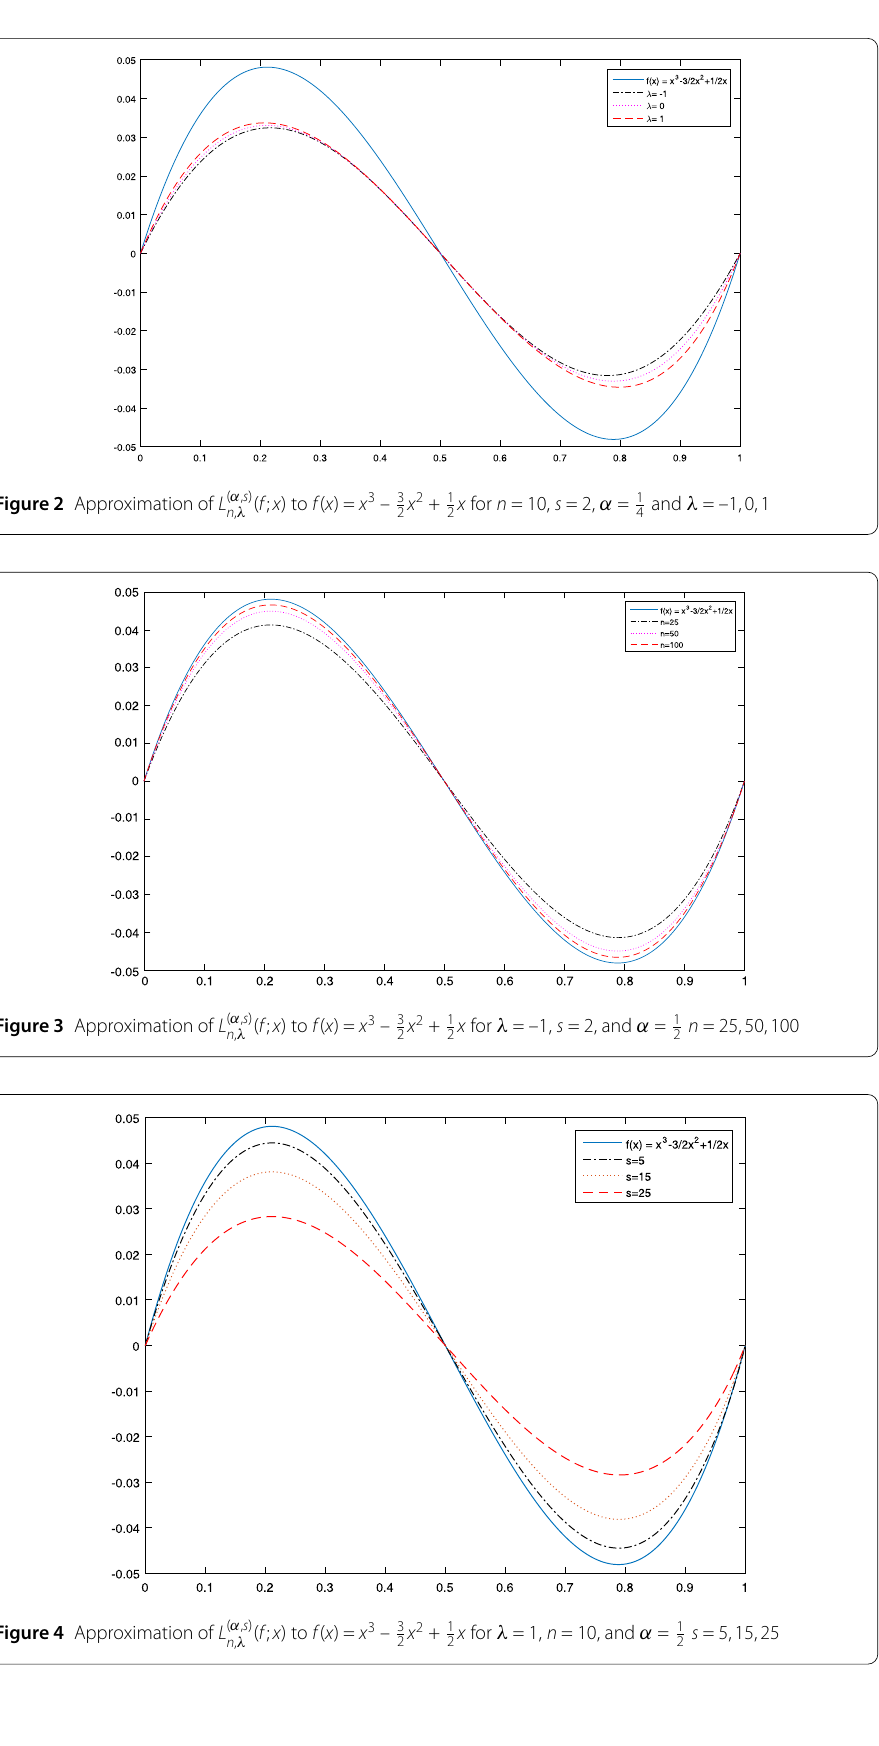
Figure 4 Approximation of L ( α , s )